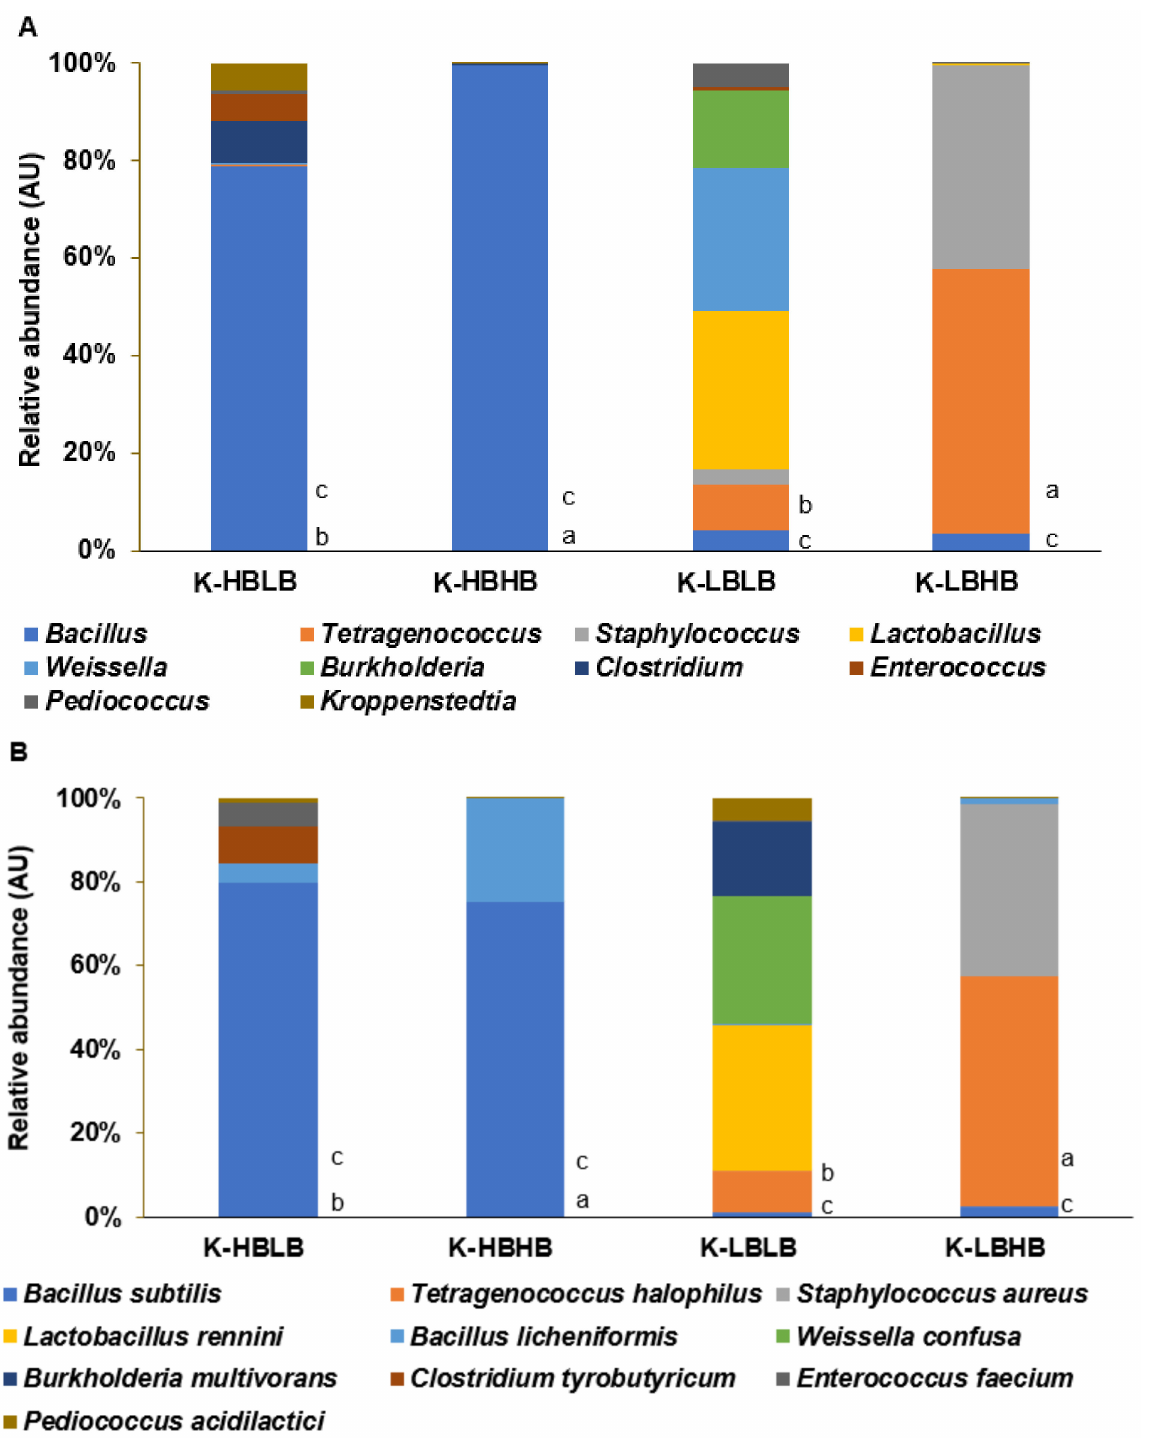
Figure 1. Relative abundance of bacteria in traditionally made kanjang according to Bacillus and bioamines contents. ( A ). The genus level ( B ). The species level. K-HBLB, TMK with high contents of Bacillus spp. and high biogenic amines; K-HBHB, TMK with high contents of Bacillus spp. and low biogenic amines; K-LBHB, TMK with low contents of Bacillus spp. and high biogenic amines; K-LBLB, TMK with low contents of Bacillus spp. and low biogenic amines. a–c Different letters beside the bars indicated a significant difference among the groups by Tukey test at p <